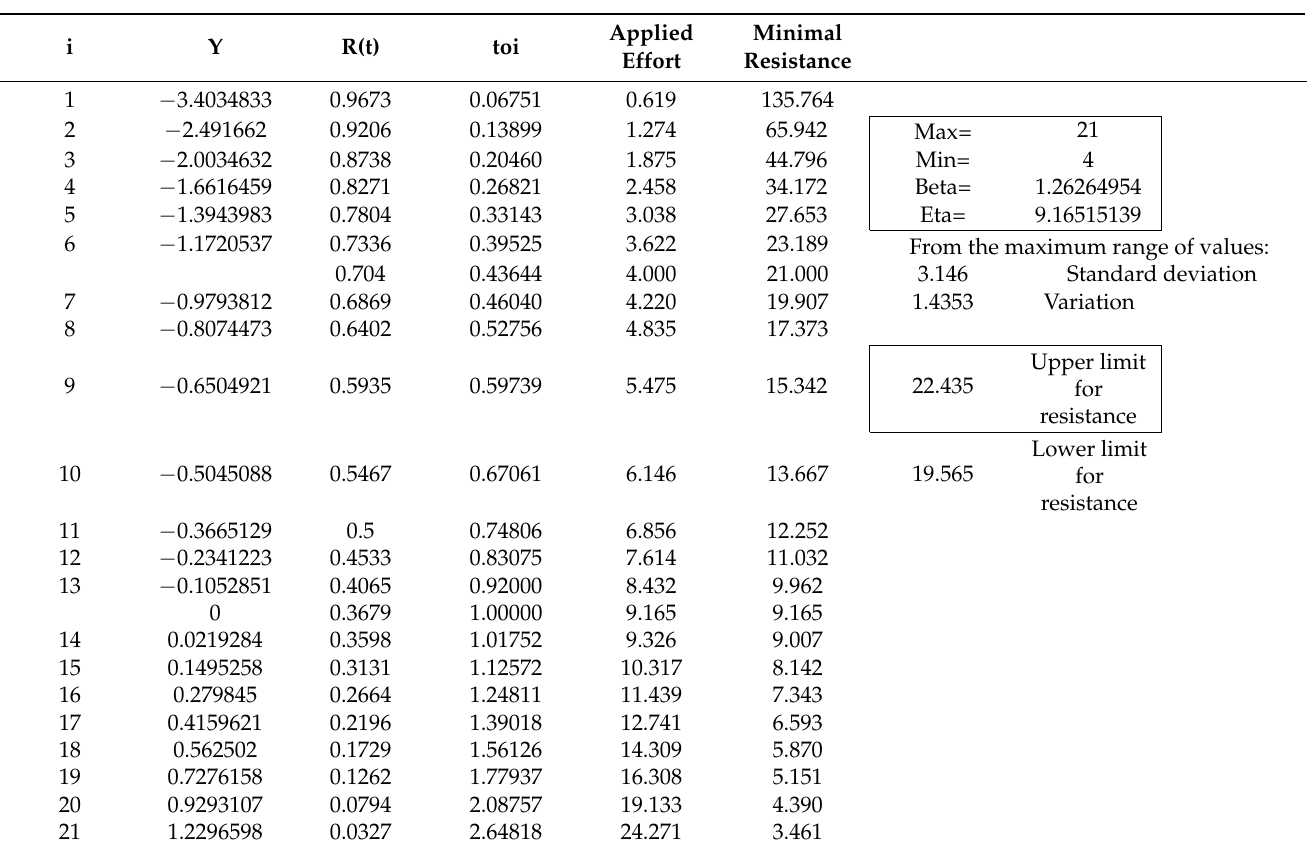
Table 17. Calculation of the β and η parameters using the minimum and maximum values of